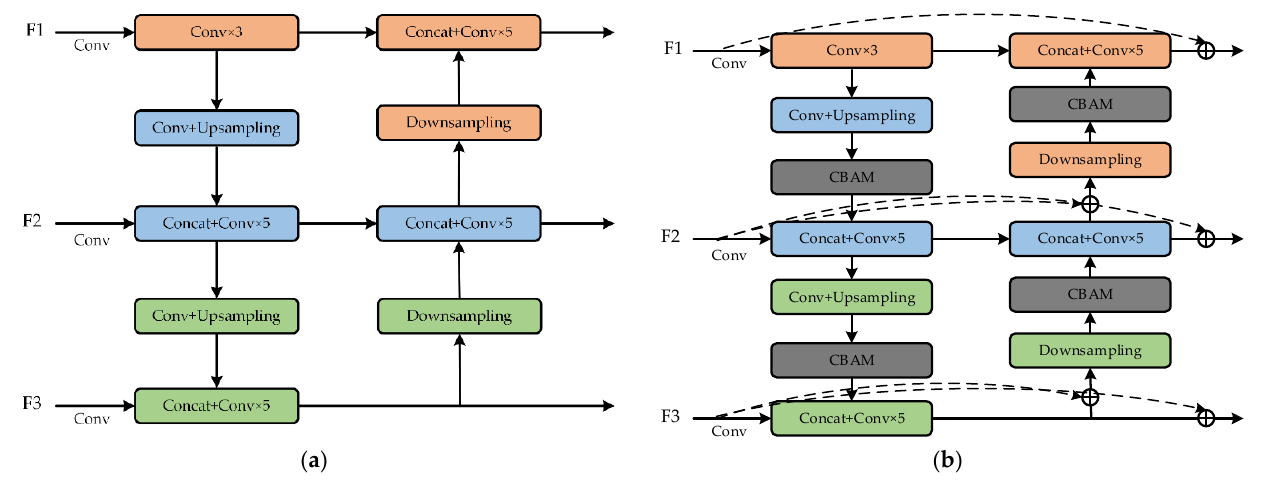
Figure 3. The structure of PAN and APAN: ( a ) PAN; ( b ) APAN.